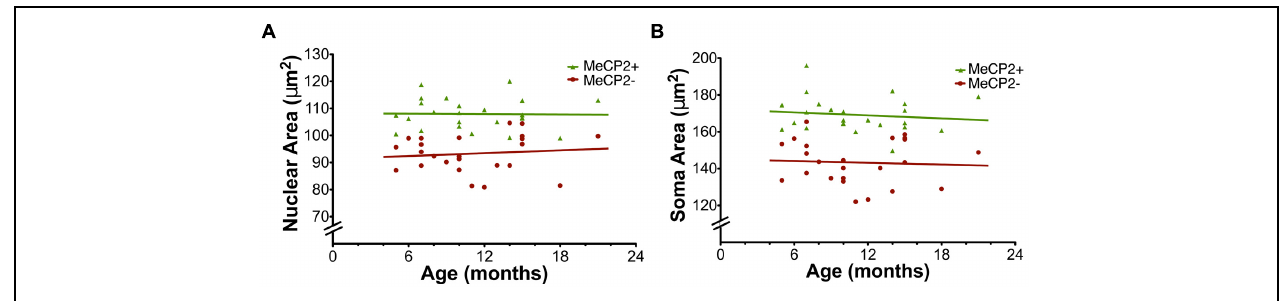
FIGURE 9 | Age does not affect nuclear and soma areas. (A) Nuclear area in MeCP2 + and MeCP2 − neurons is not altered across age (MeCP2 + R 2 = 0.00040 and MeCP2 − R 2 = 0.012). (B) Soma area in both genotypes is not affected by age (MeCP2 + R 2 = 0.015 and MeCP2 − R 2 = 0.0031).